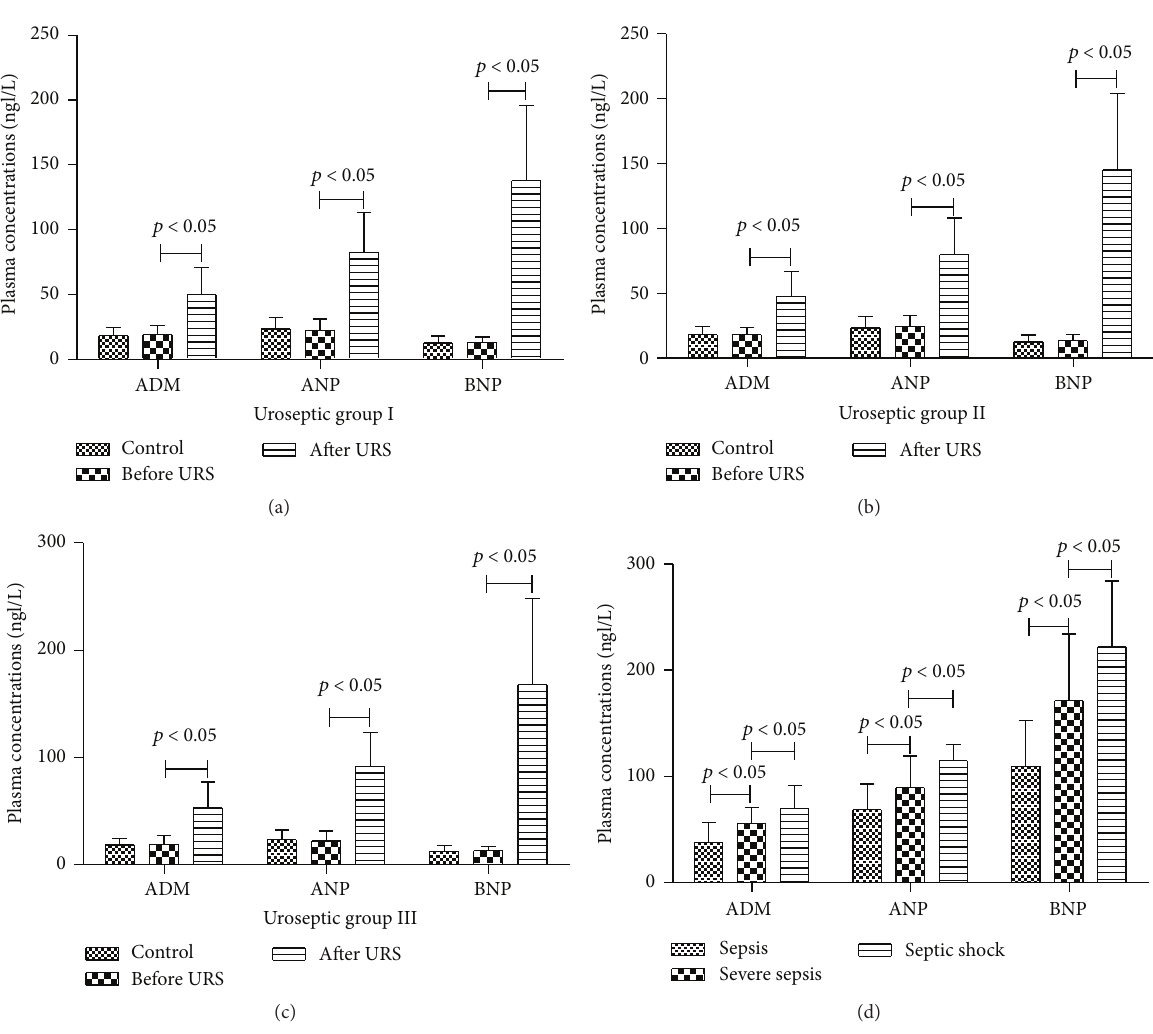
Figure 1: (a) Plasma concentrations of ADM, ANP, and BNP in controls and uroseptic group I before and after URS under 80 mmHg. (b) Plasma concentrations of ADM, ANP, and BNP in controls and uroseptic group II before and after URS under 120 mmHg. (c) Plasma concentrations of ADM, ANP, and BNP in controls and uroseptic group III before and after URS under 160 mmHg. (d) Plasma concentrations of ADM, ANP, and BNP in URS-induced sepsis, severe sepsis, and septic